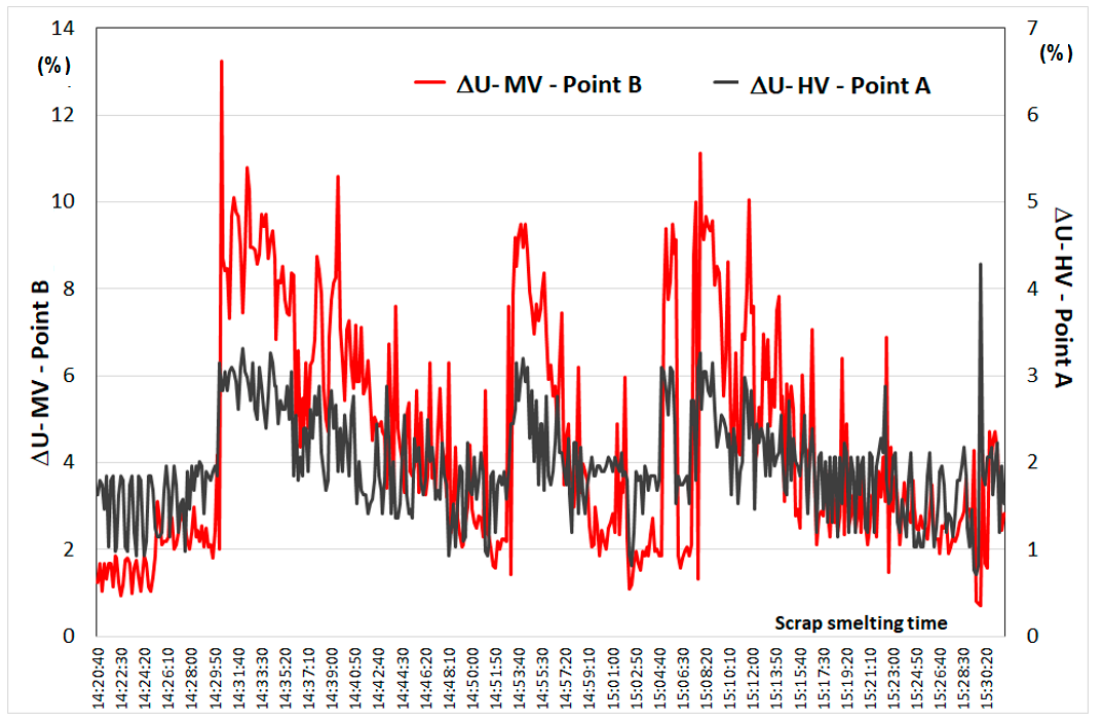
Figure 2. Voltage changes Δ U recorded during one melt: steelworks supply line: point A; steelworks supply line: point B.